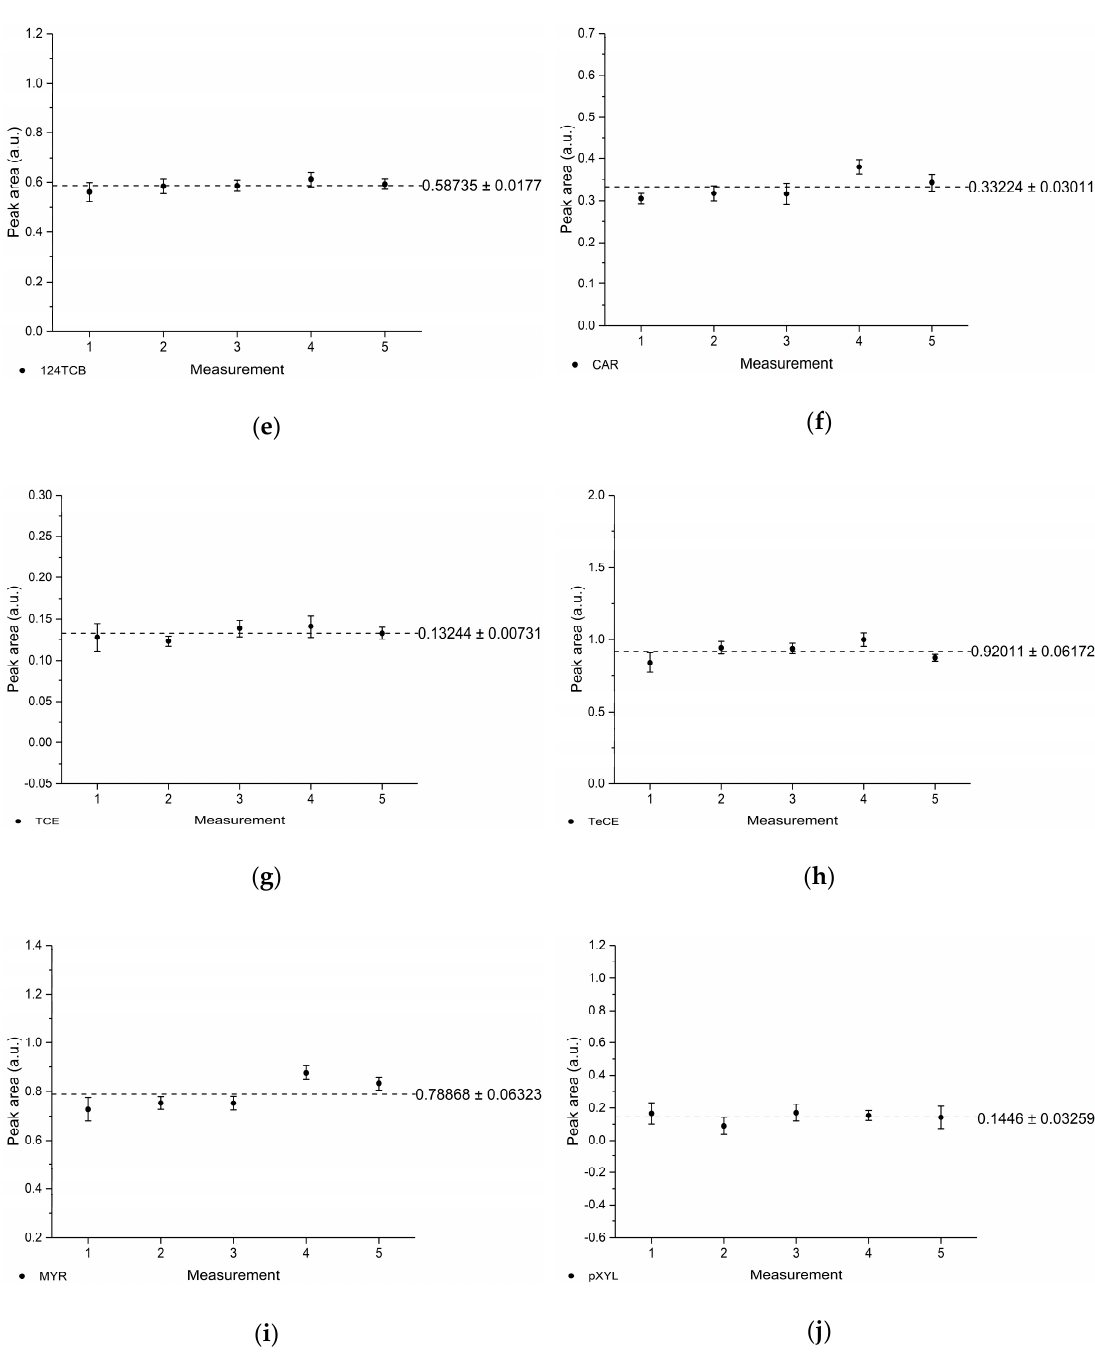
Figure 8. Reproducibility of the MIR chemical sensor system determined from five independent sample measurements demonstrated for ( a ) 13DCB, ( b ) pCYM, ( c ) EB, ( d ) 12DCB, ( e ) 124TCB, ( f ) CAR, ( g ) TCE, ( h ) TeCE, ( i ) MYR, and ( j ) pXYL.